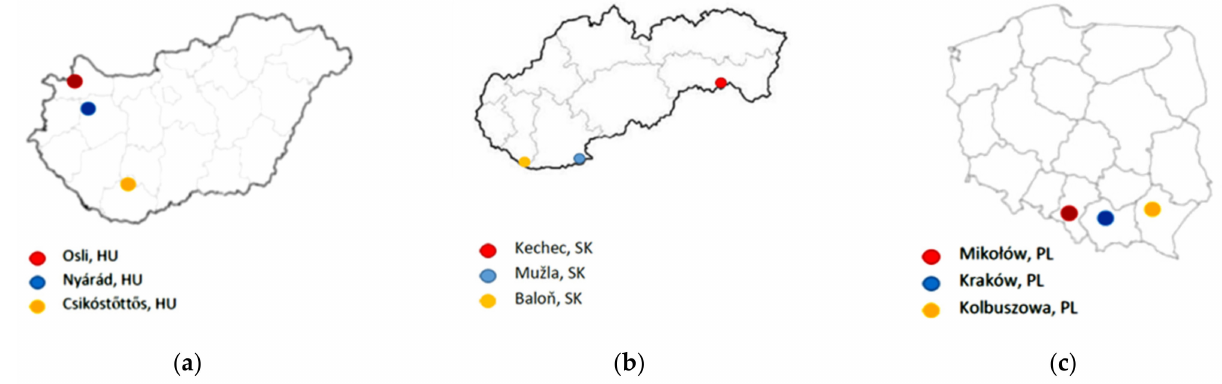
Figure 2. Place of origin of Hungarian- ( a ), Slovak- ( b ), and Polish-origin ( c ) goldenrod honeys.